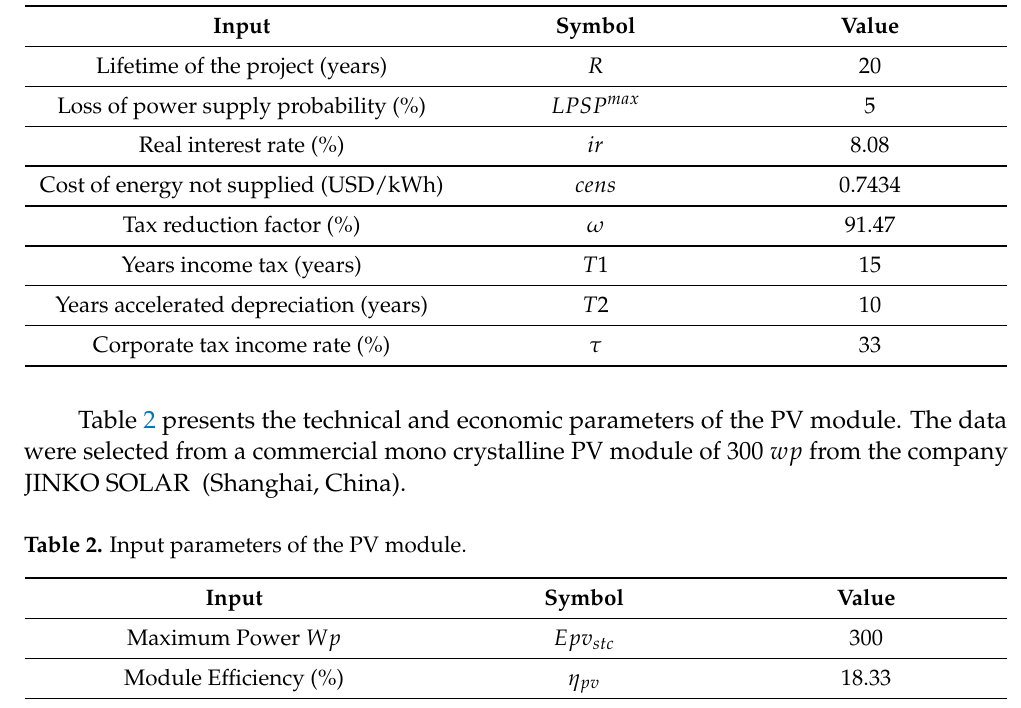
Table 1. Input parameters of the project.